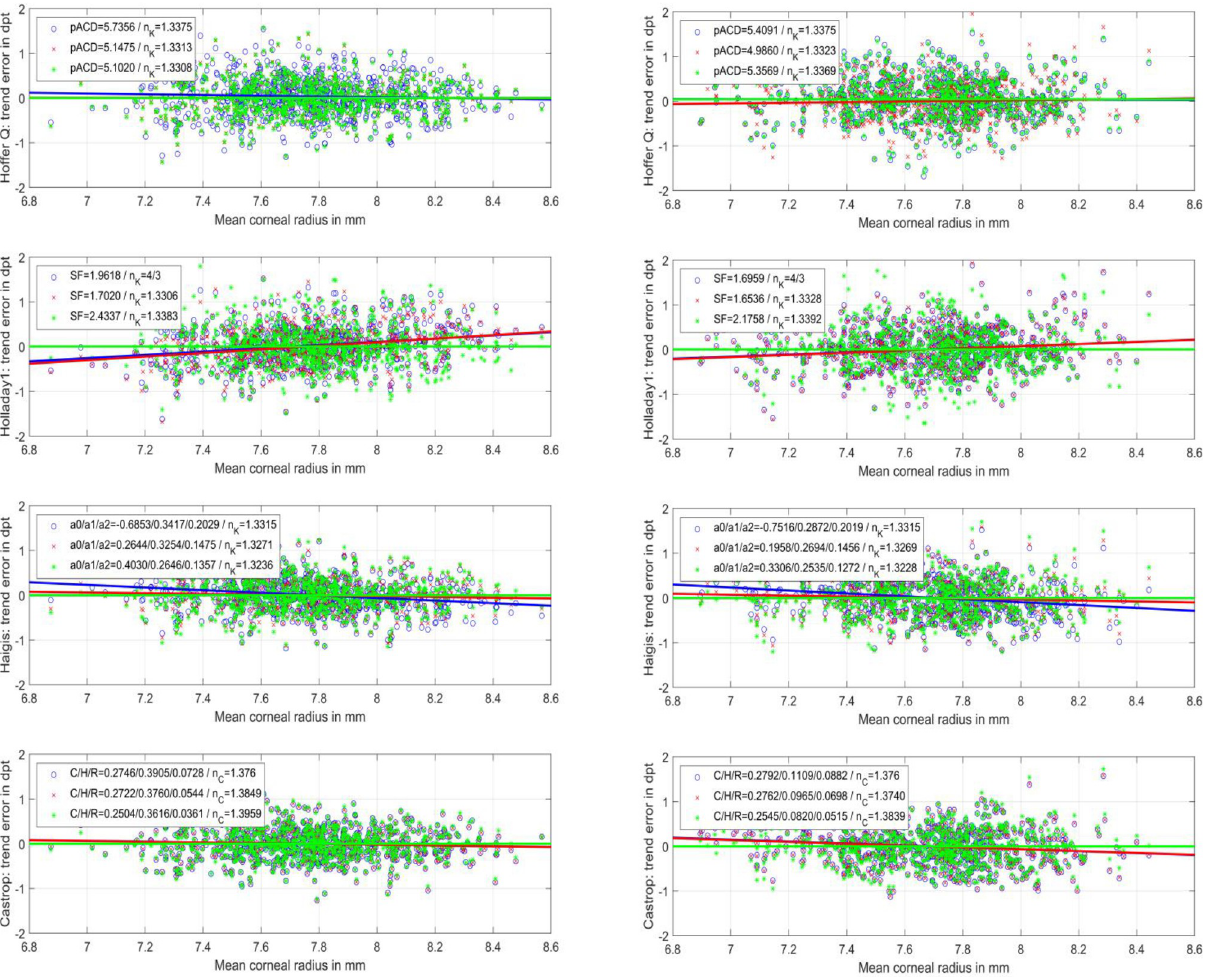
Fig 3. Scatterplot of prediction error (PE, measured spherical equivalent refraction–formula predicted refraction) versus the corneal radius for the Hoffer Q, Holladay1, Haigis, and Castrop formula for dataset 1 (Hoya Vivinex, N = 888, left graph) and dataset 2 (Alcon SA60AT, N = 822, right graph). Formula constant optimisation was performed to minimise the sum of squared prediction errors PE: Situation A) (blue o-markers and blue line indicating the trend error derived from linear regression) refers to the ‘classical’ formulae with standard nK/nC values; with situation B) (red x-markers and red line indicating the trend error derived from linear regression) the formula constants and nK/nC in the main part of the formula were varied for optimisation; with situation C) (green � -markers and green line indicating the trend error derived from linear regression) the formula constants and nK/ nC in the main part of the formula were varied to minimise for PE and the PE trend error over corneal radius. Situation D) is not shown in this figure.